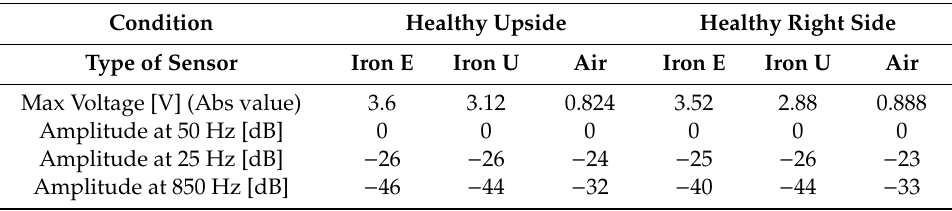
Table 2. Results of healthy